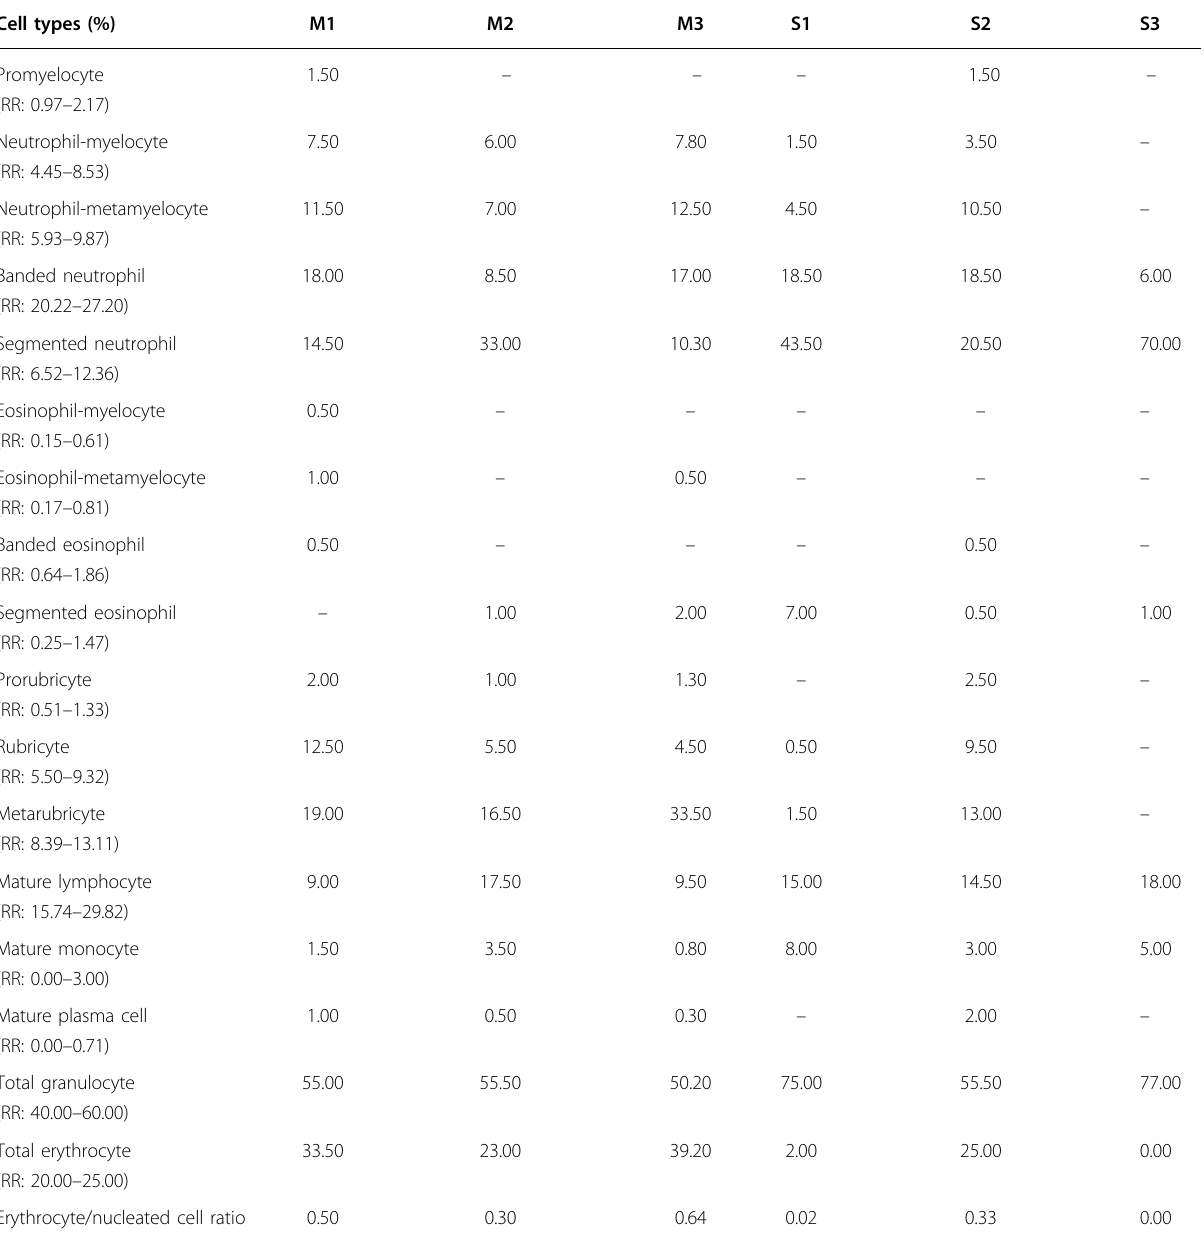
Table 2 Bone marrow examination in six COVID-19